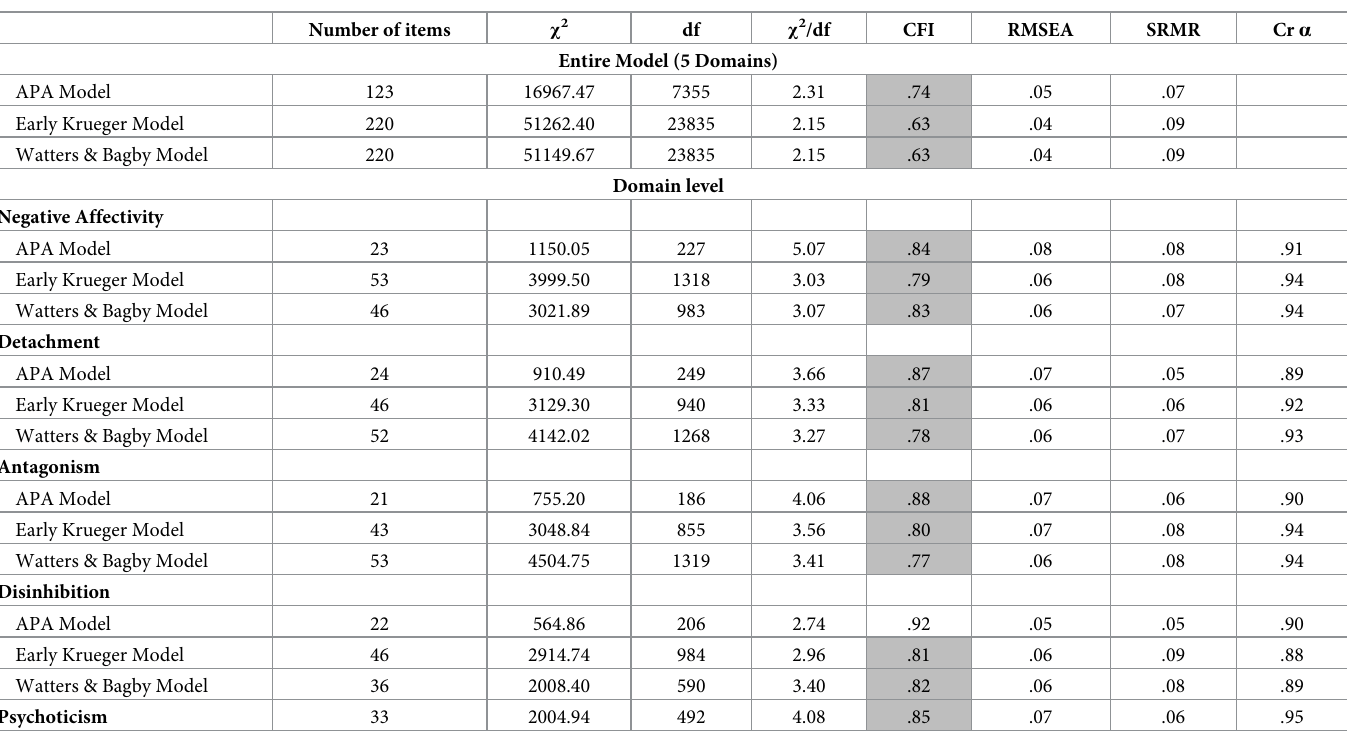
Table 1. Fit indexes of CFA of factor structures of